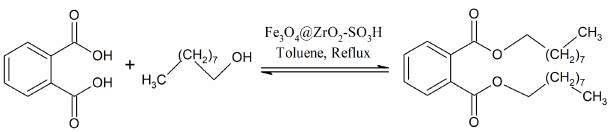
Scheme 2. Esterification of phthalic acid by n -nonanol in the presence of Fe 3 O 4 @ZrO 2 -SO 3 H.